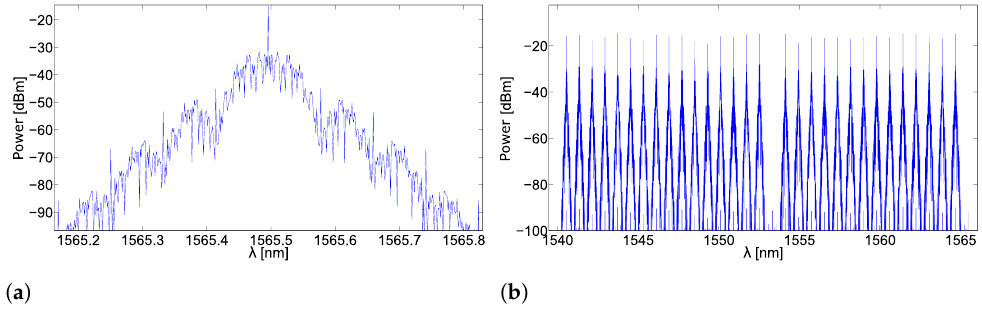
Figure 12. Spectra of other demultiplexed signals: ( a ) Spectrum of the 17th demultiplexed signal, ( b ) Spectra of other demultiplexed